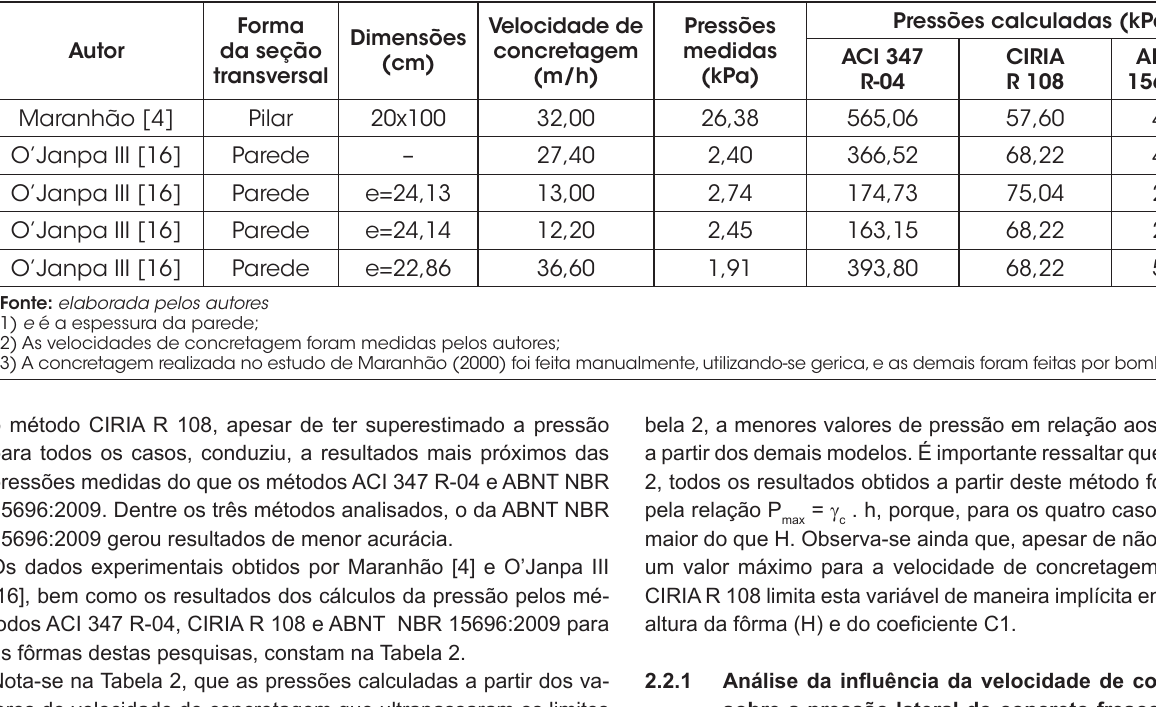
A Figura 6 representa o gráfico da pressão calculada versus velo-